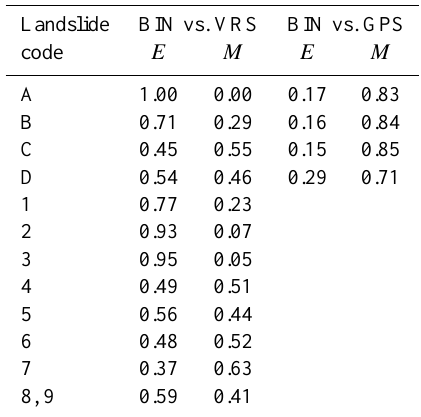
Table 2. Landslide cartographic errors. E (error index) computed using Eq. (1), M (matching index) computed using Eq. (2). For landslide codes see (Fig. 2). BIN, mapping obtained using the rangefinder binocular; VRS, mapping obtained through visual reconnaissance survey; GPS mapping obtained by walking the GPS receiver along the landslide perimeter. Landslide BIN vs. VRS BIN vs.